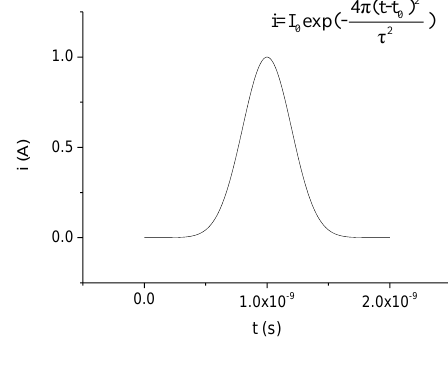
Figure 8. Gaussian pulse. Figure 8. Gaussian